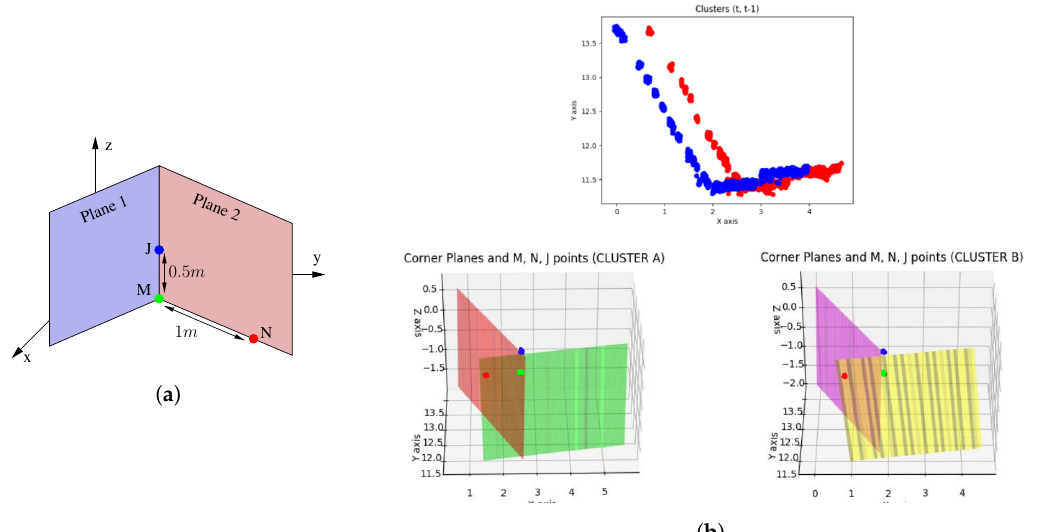
Figure 13. Evaluation of synthetic points: ( a ) Nomenclature and position of calculated synthetic points; and ( b ) result of synthetic points detection in real clusters of two consecutive time